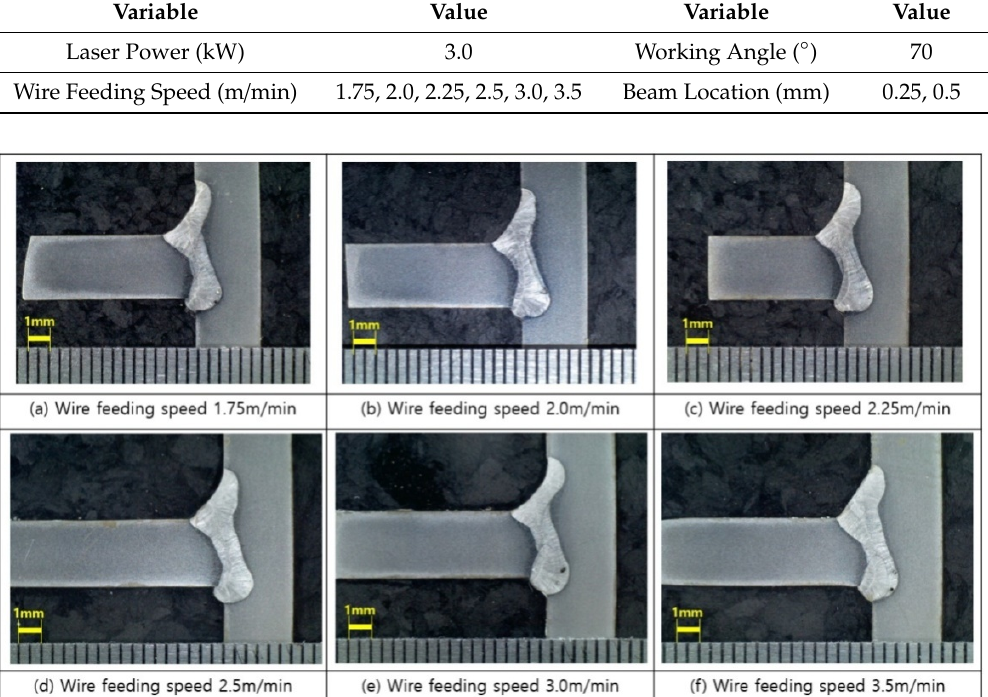
Table 10. Welding conditions of Step 3 (wire feeding speed change, beam location change, 12 cases).